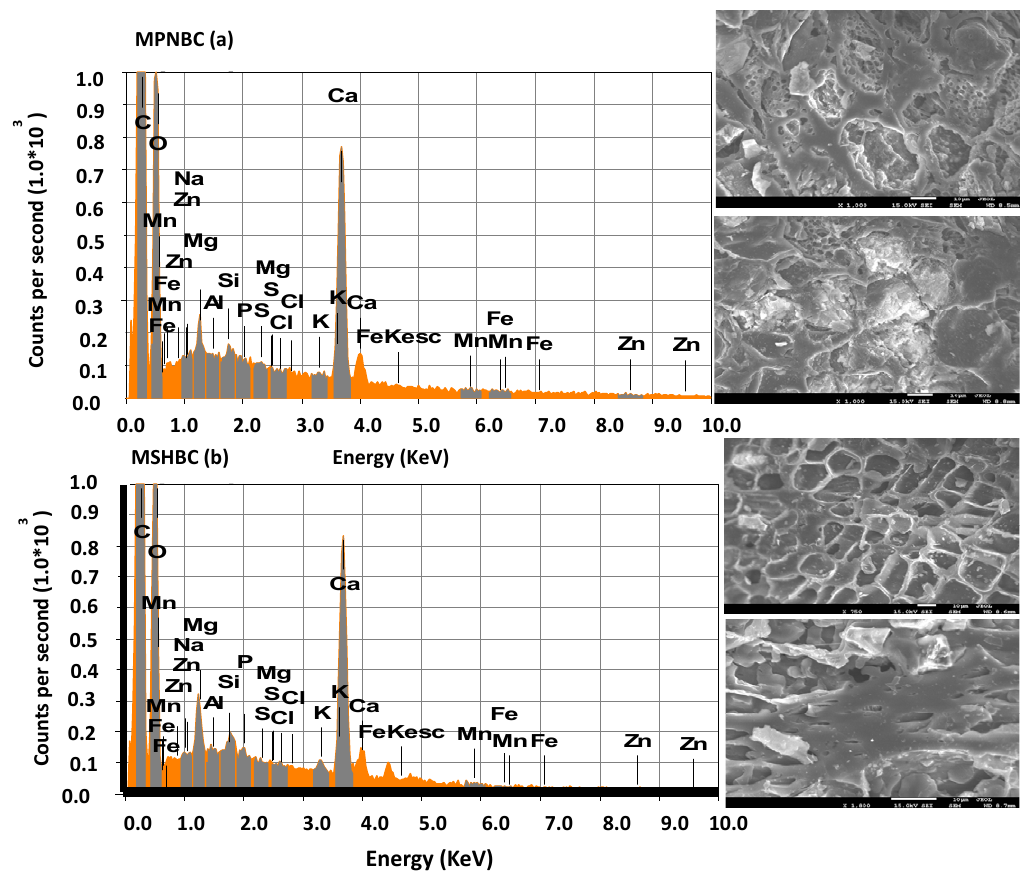
Fig. 1: Presentation of EDX graphical output and FESEM images for elemental composition and surface morphological analysis respectively, of Mupane (a) and Mushuma (b) Tree barks biochar pyrolyzed at 600 ˚C for 2 hr Table 1: The chemical composition extracted from the EDX analysis for Mupane and Mushuma barks biochar modified at 600 ˚C for 2 hrs. in mass and moles units.